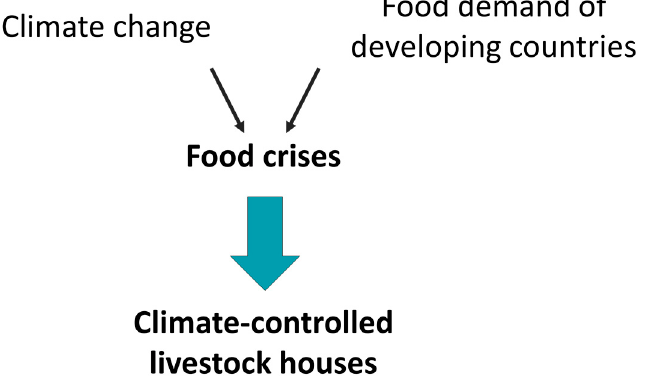
Figure 4. Schematization of climate-controlled livestock houses as a potential solution that may contribute towards avoiding food crises due to climate change and the increasing food demands of developing countries.